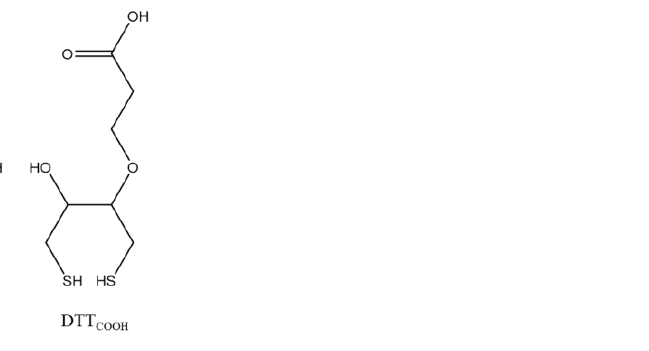
Figure 2. Dithiothreitol (DTT) and 3-dithiothreitol propanoic acid (DTT COOH ). DTT COOH ’s antifouling capability against untreated human serum was assessed using the quartz crystal microbalance with dissipation monitoring (QCM-D). QCM-D is a mass- sensitive sensor involving layers immobilized on the gold surface of a piezoelectric quartz disc. An applied electric field oscillates the disc, allowing changes in mass on the disc’s surface to be detected by a frequency shift relative to the crystal’s fundamental